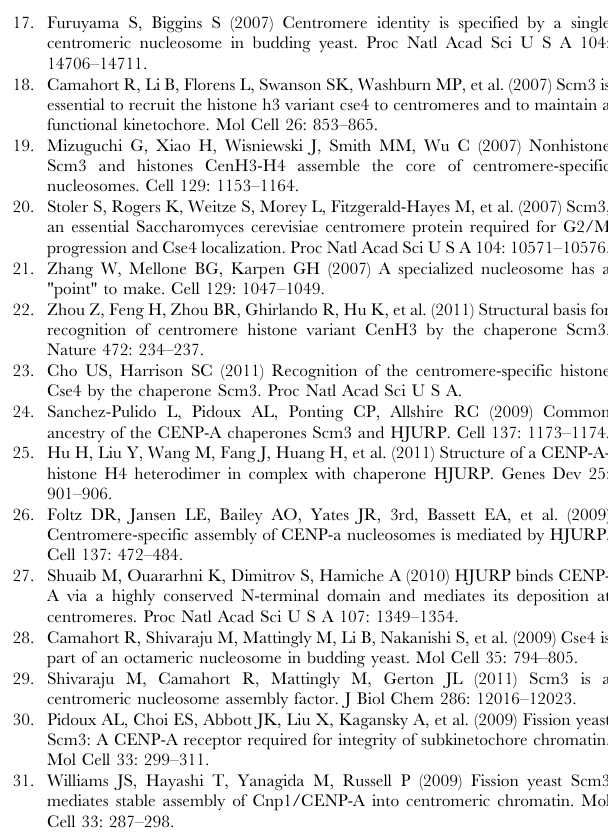
Figure S6 Centromeric enrichment pattern of Scm3p expressed from a GAL1 promoter ( GALSCM3 ) through the cell cycle. Wild- type strain expressing HA tagged Scm3p from GAL1 promoter (RC100) was grown in minimal media with galactose (2%) at 30 u C, treated with nocodazole for 2 hours to synchronize cells in G2/M, washed, and released into minimal media containing a - factor. Samples were taken at time points (min) after release from G2/M arrest. (A) DNA content was determined by FACS. (B) Cell cycle stages were determined based on cell morphology and nuclear position by microscopic examination of 200 cells for each time point. (C) Enrichment levels of Scm3p at CEN3 . ChIP